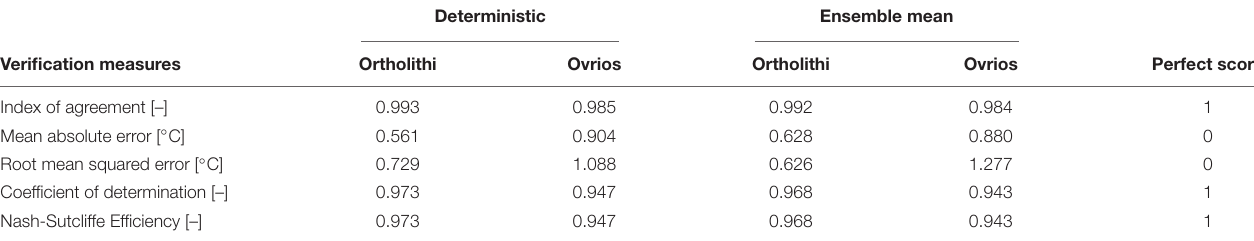
TABLE 3 | Results of verification measures for deterministic SWT and ensemble mean